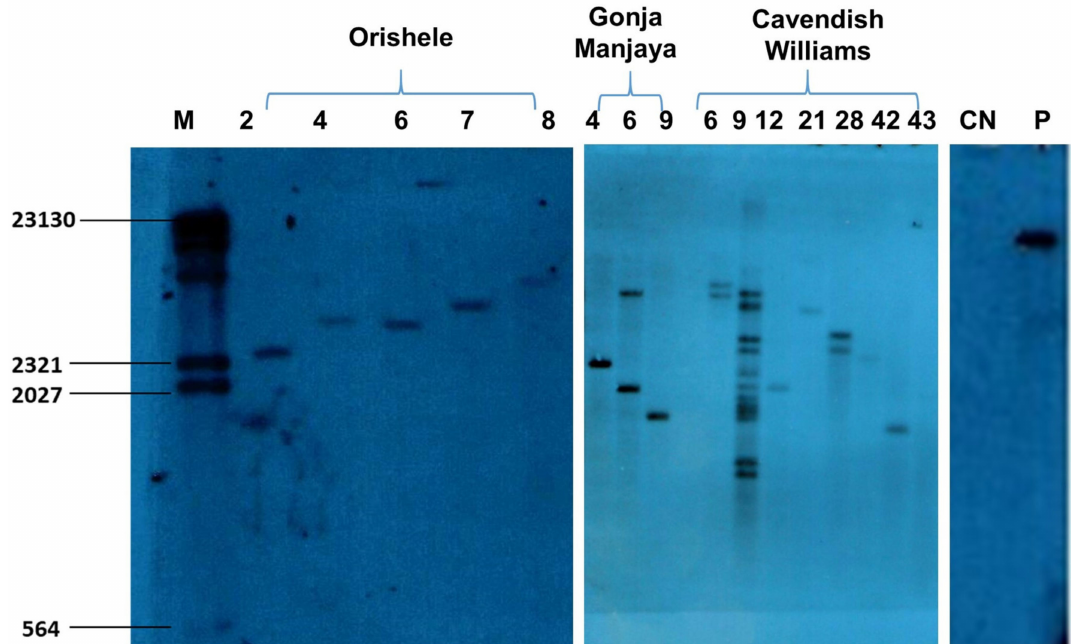
Figure 5. Southern blot analysis to confirm the integration of AChE transgene in selected transgenic events representing plantain (Orishele and Gonja Manjaya) and banana (Cavendish Williams) cultivars. M—molecular marker; CN—control nontransgenic plant; P—plasmid DNA as positive